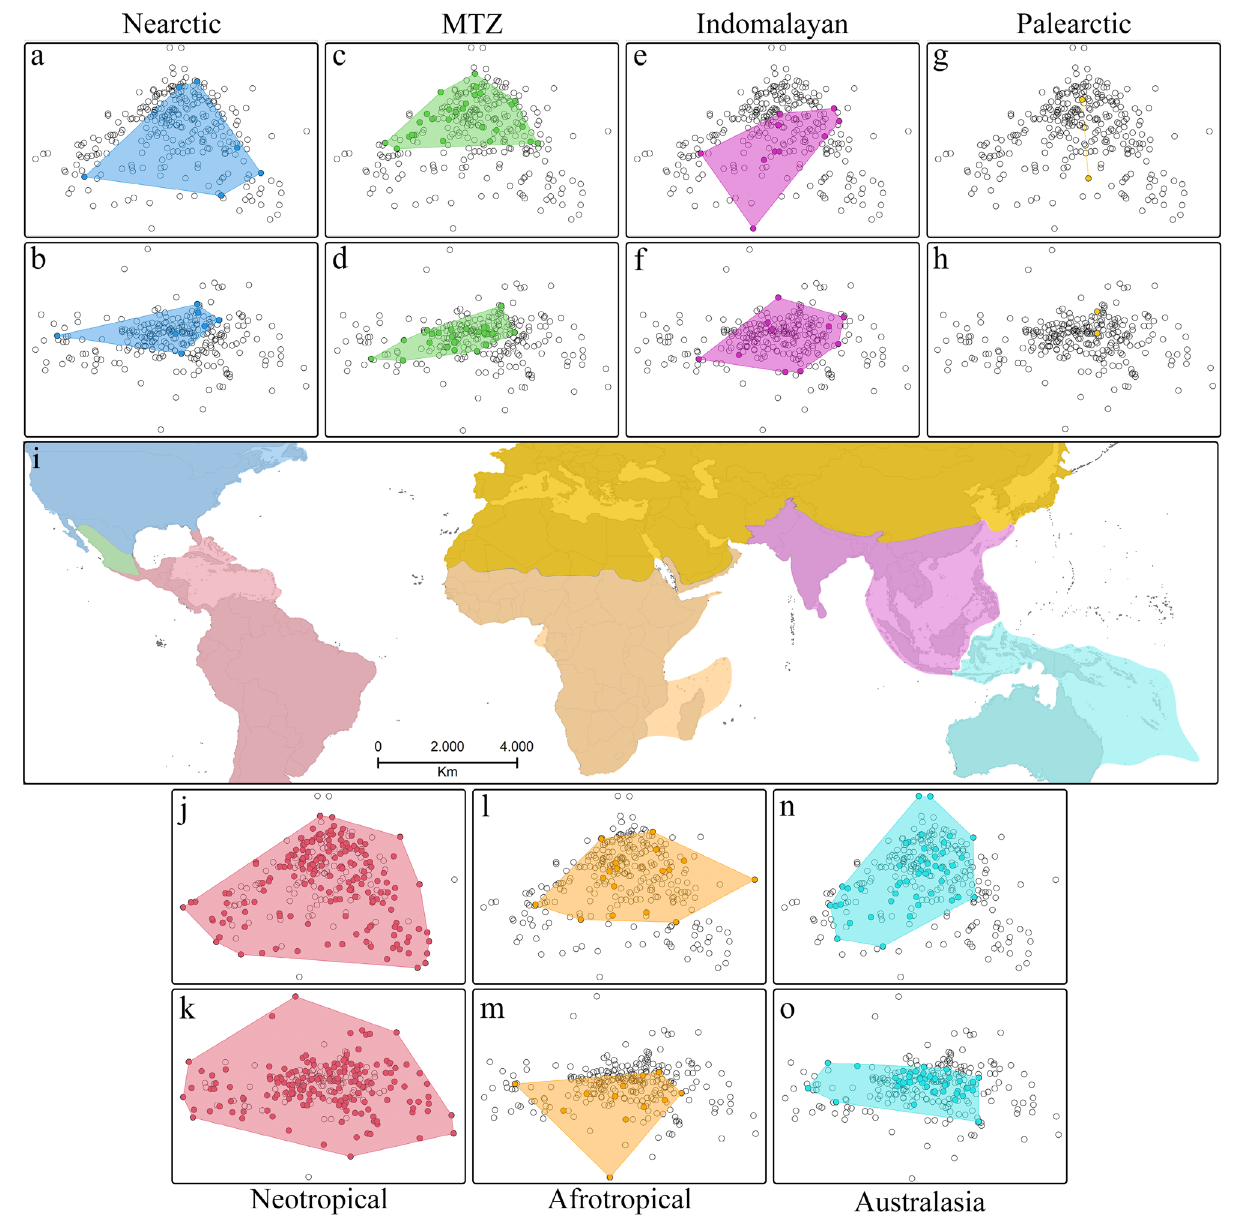
Figure 4. Morphospace plots in biogeographic realms based on male schizomid flagella. ( a ) Nearctic, dorsal. ( b ) Nearctic, lateral. ( c ) Mexican Transition Zone (MTZ), dorsal. ( d ) MTZ, lateral. ( e ) Indomalayan, dorsal. ( f ) Indomalayan, lateral. ( g ) Palearctic, dorsal. ( h ) Palearctic, lateral. ( i ) Map shows locations of biogeographic zones. ( j ) Neotropics, dorsal. ( k ) Neotropics, lateral. ( l ) Afrotropics, lateral. ( m ) Afrotropics, lateral. ( n ) Australasian, dorsal. ( o ) Australasian,